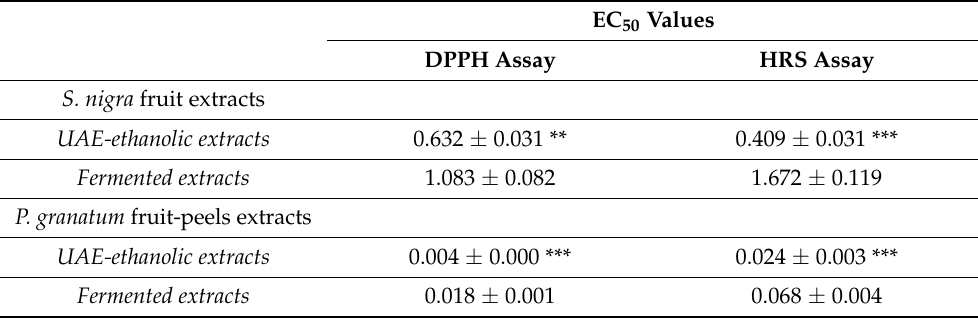
Table 5. Antioxidant capacity (in terms of EC 50, mg mL − 1 ) of UAE-ethanolic and fermented extracts of S. nigra fruits (elderberry) and P. granatum fruit-peels (pomegranate)